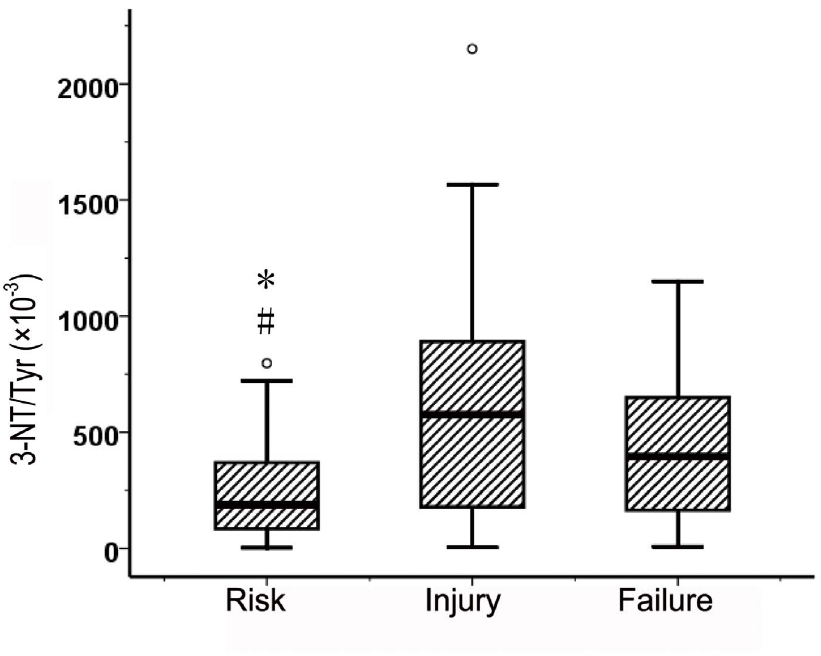
Figure 2. 3-NT/Tyr in 158 patients with AKI stratified by RIFLE stages. * t test p =0.002, AKI patients in risk stage compared to in injury stage; # t test p =0.007, AKI patients in risk stage compared to in failure stage.